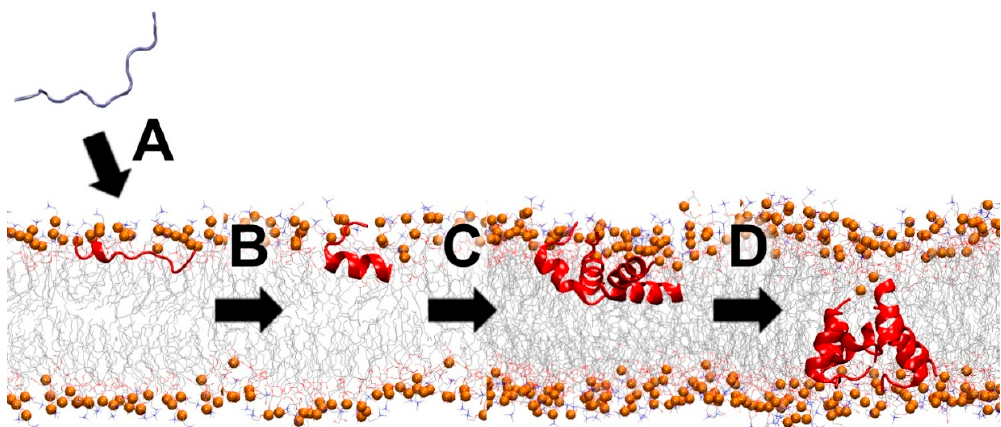
Figure 5. Schematic partitioning for membrane-active peptides (MAPs) that interact with the lipid bilayer. Water-soluble peptides spontaneously ( A ) bind onto the interface of the lipid bilayer, ( B ) fold and ( C ) aggregate at the membrane interface, and ( D ) form a channel and / or pore in the lipid membrane. Orange spheres represent the phosphorus atoms of the lipid headgroups.